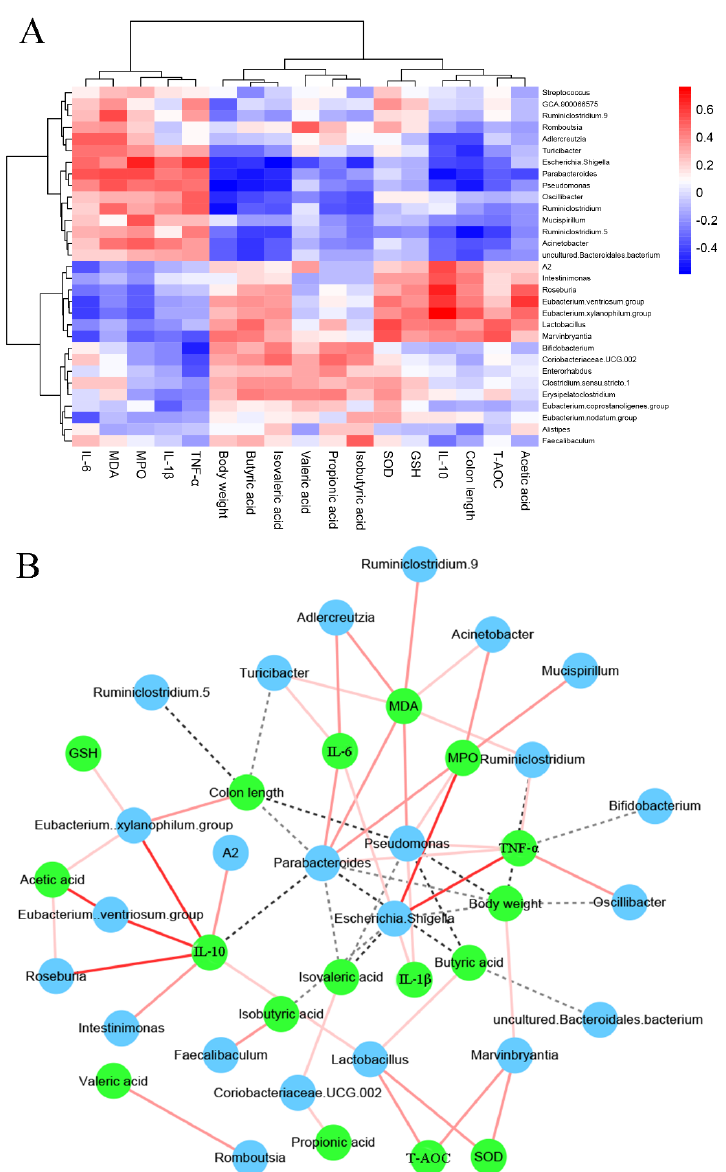
Figure 9. Association analysis between the key phylotypes of intestinal microbiota and colitis − related parameters. Heatmap of Spearman’s correlation ( A ) and network of Spearman’s correlation ( B ).